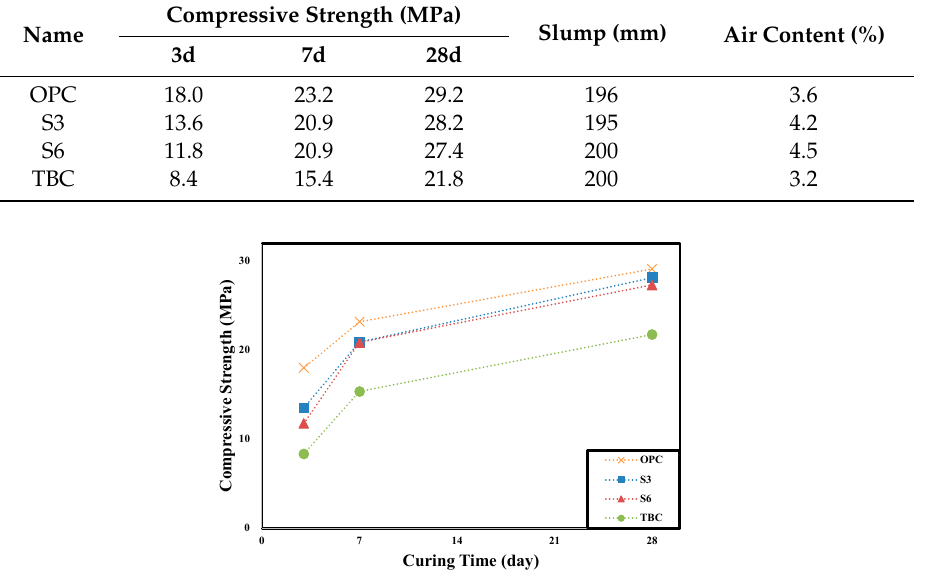
Figure 8. Variation of compressive strength on curing days by specimens.